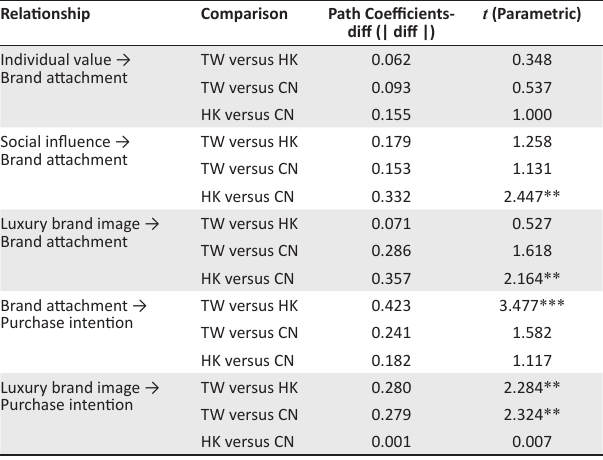
TABLE 5: Multi-group comparison test results. Relationship Comparison Path Coefficients-